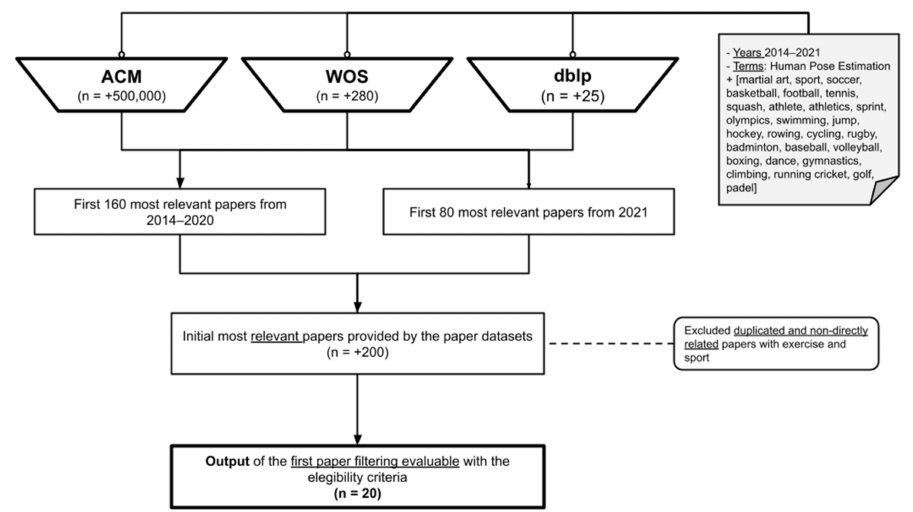
Figure 1. Paper selection flow